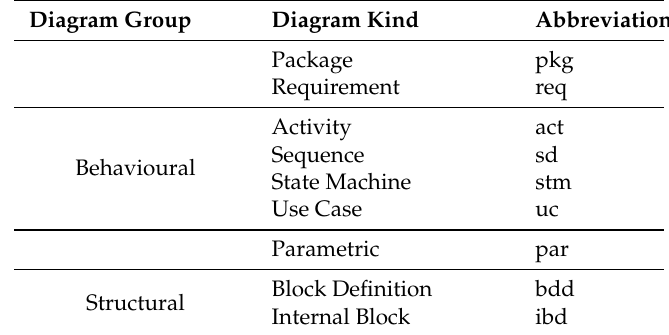
Table 1. SysML diagrams and their abbreviations